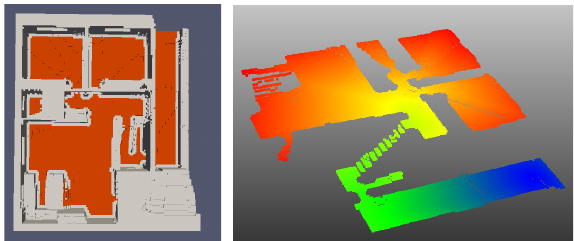
Fig. 6. Navigable floorspace (left) and distances to exit point (right) in voxel model reconstructed from point clouds